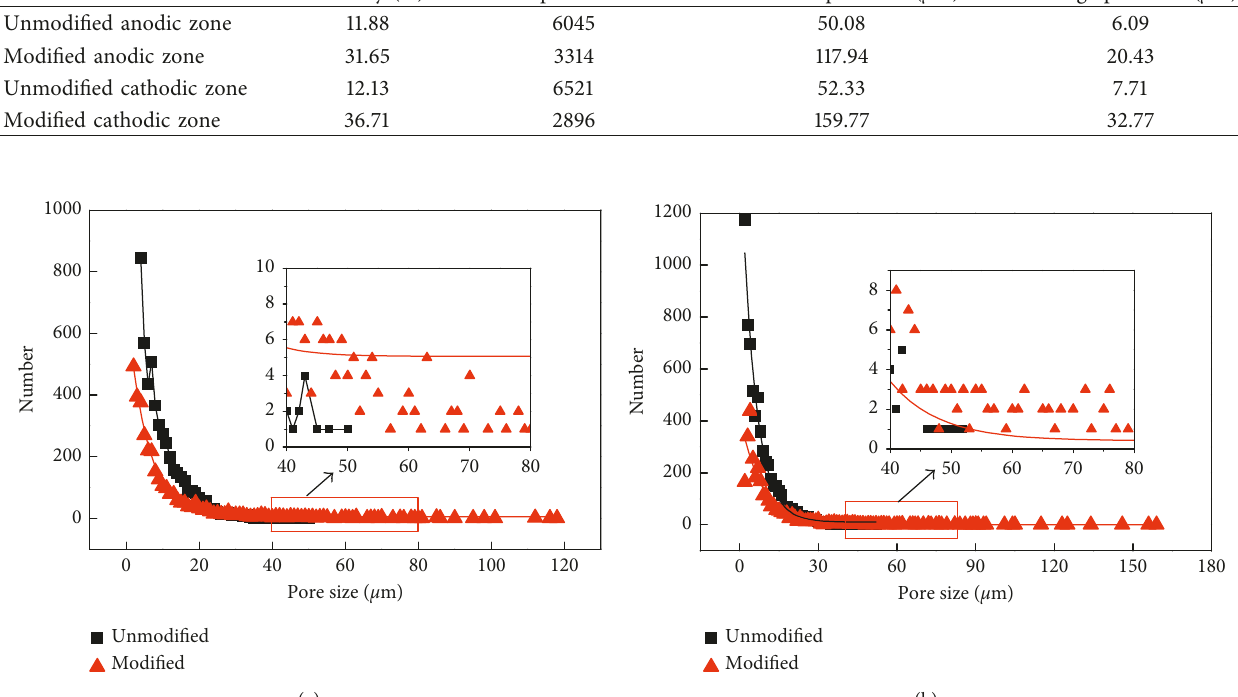
Figure 8: Pore size distribution of samples with a diameter of 2.54mm before and after modification. (a) Sample modified in the anodic zone; (b) sample modified in the cathodic zone.